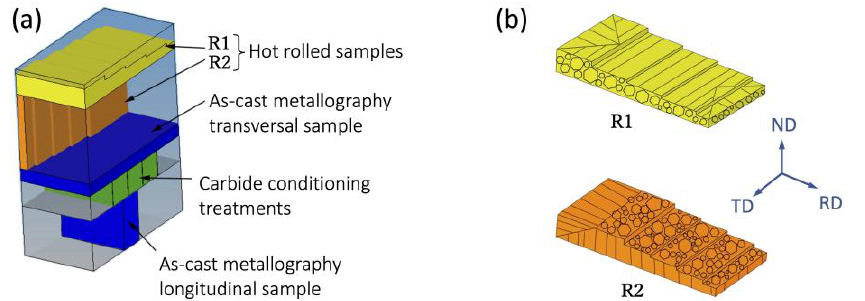
Figure 1. Prismatic ingot. ( a ) Sectioning scheme. ( b ) CGPO scheme profile in samples R1 and R2. The lines and hexagons represent the growth direction and the cross-section of columnar grains, respectively. The directions (D) used for hot rolling are indicated as N (normal), R (radial) and T (transversal).